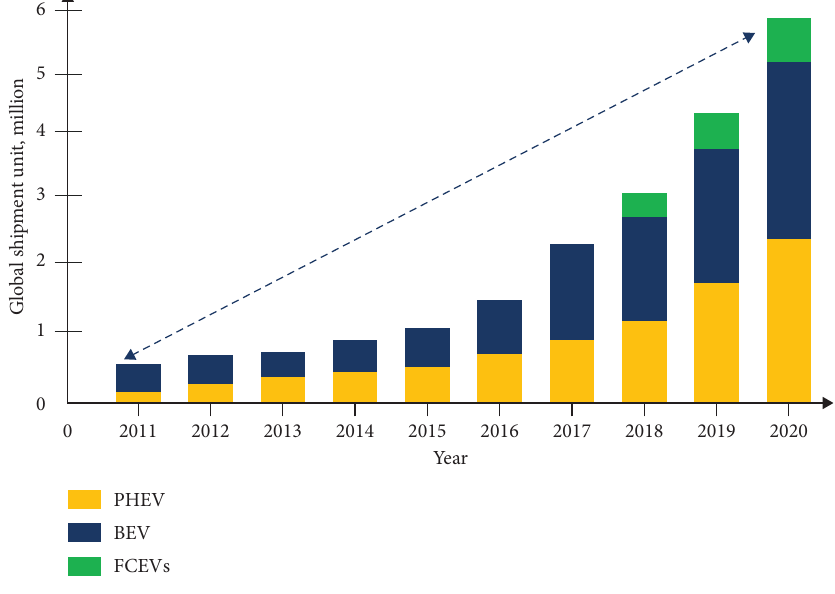
Figure 2: Global EV/HEV shipment estimates Table 1: Comparison of alternative vehicle confgurations with various powertrain models. Model